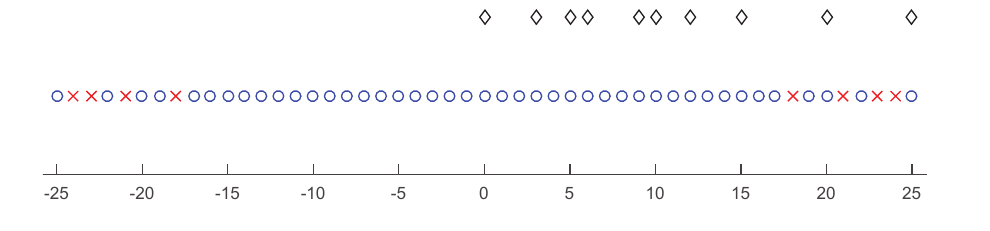
Figure 1. An example extended co-prime array configuration with M = 3 and N = 5. The black diamonds are physical sensors. The blue circle represents the difference coarray, while the red cross represents the